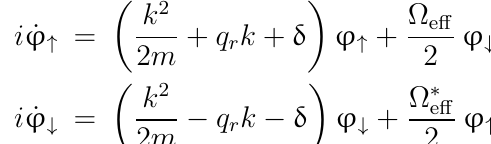
and κ are the p